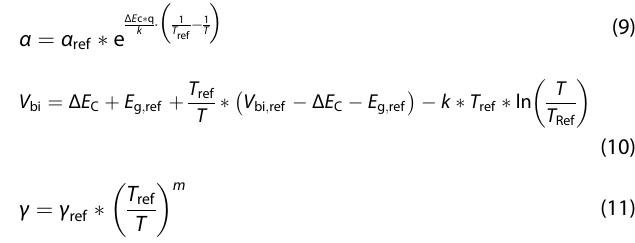
Figure 4a shows the irradiance dependence of shunt resistance for different CIGS modules. The power relation (7) was used to fi t the data for each module to obtain the empirical parameter u that de fi nes the relation. The values extracted from the data are given in inset table of Fig. 4a.